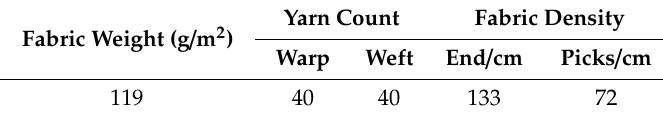
Table 1. Cotton fabric specifications.